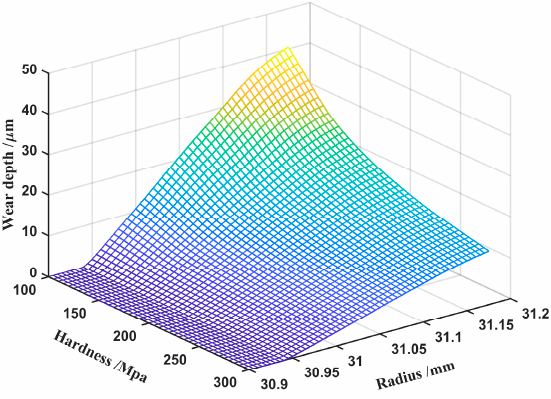
Figure 20. Effect of hardness on wear depth.